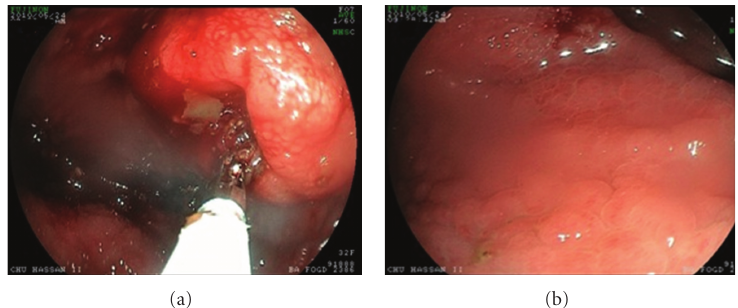
Figure 2: Upper gastrointestinal endoscopy revealing (a) duodenal stenosis with proximal dilatation, (b) mosaic mucosal pattern with scalloped configuration of duodenal folds.